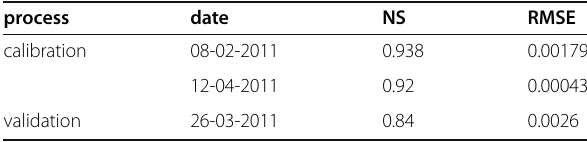
Table 4 Calibration and validation performance